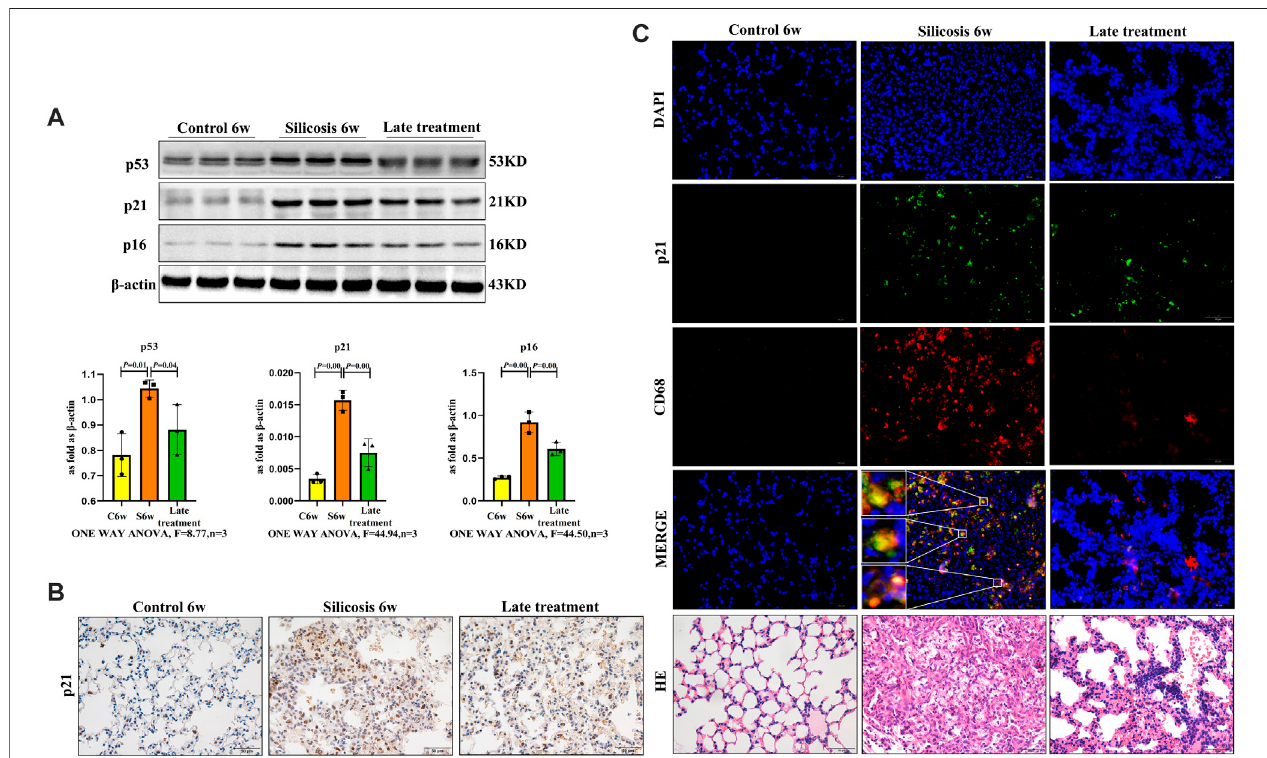
FIGURE 3 | Quercetin attenuates macrophage senescence in silicosis model. (A) p16, p21 and p53 expression by western blot. (B) Immunohistochemistry staining of p21 in the lung. (C) Immuno fl uorescence staining for p21 and CD68 in the lung. Data are presented as the mean ± SD. n = 3 per group.